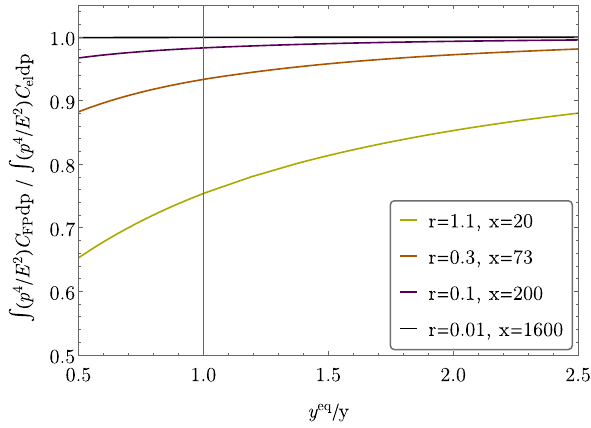
Fig. 10 The magnitude of the second moment of the Fokker-Plank approximation relative to the full scattering collision term, as a func- tion of the DM temperature, for a constant scattering amplitude and non-relativistic bath particles. We note that for thermally produced DM y eq / y < 1 can only be achieved through (annihilation) processes that lead to DM